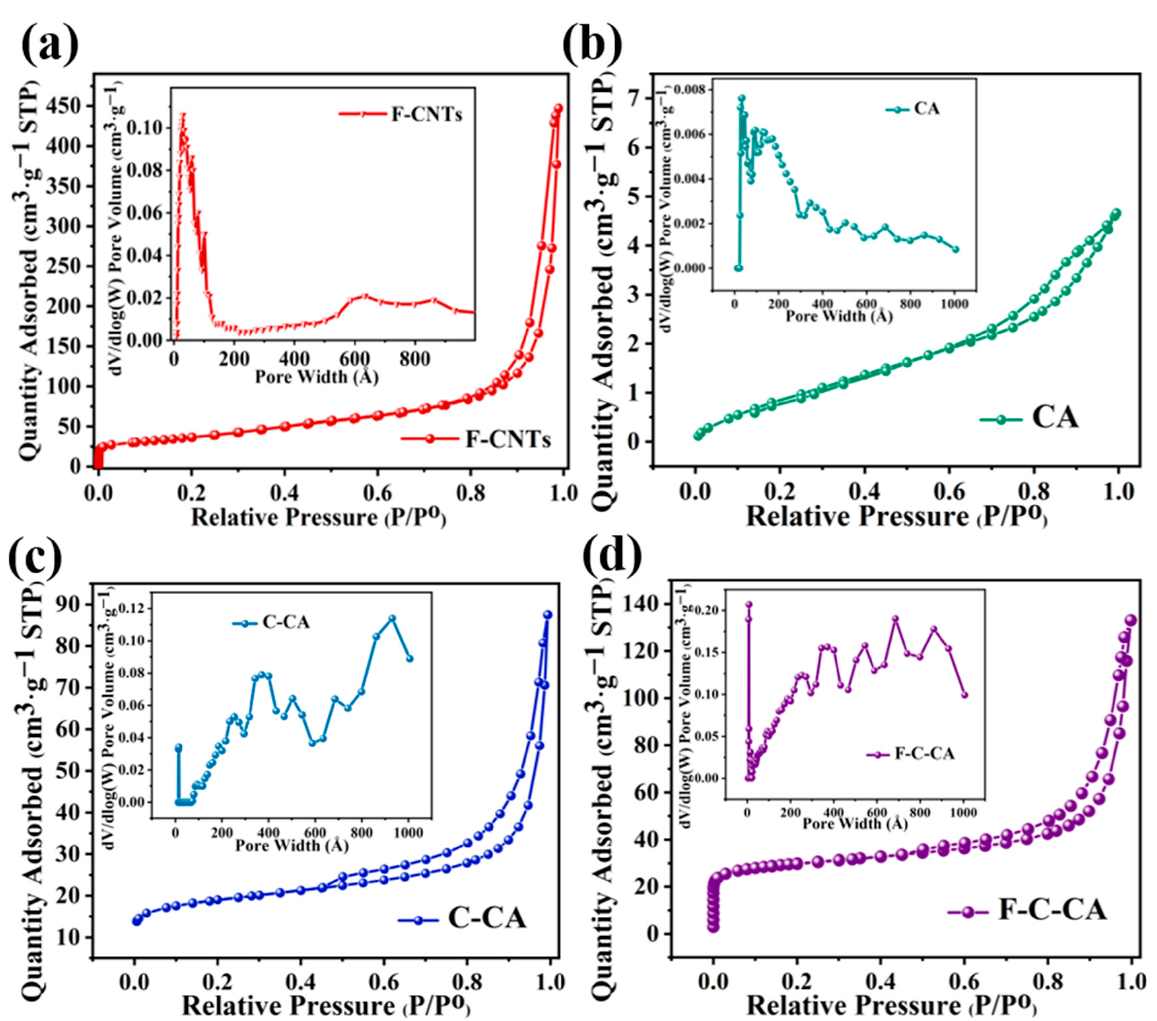
Figure 3. N 2 adsorption–desorption isotherms of: ( a ) F-CNTs, ( b ) CA, ( c ) C-CA, ( d ) F-C-CA, and the insets show the pore size distribution of the corresponding material.